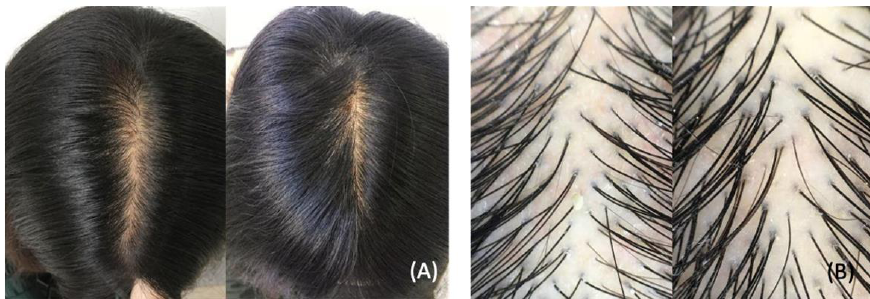
Figure 5. Stress-Related Dermatologic Manifestations during the COVID-19 Pandemic. ( A , B ) Telogen effluvium (coined “COVID scalp”) depicting thinning of hair along midline part [192].